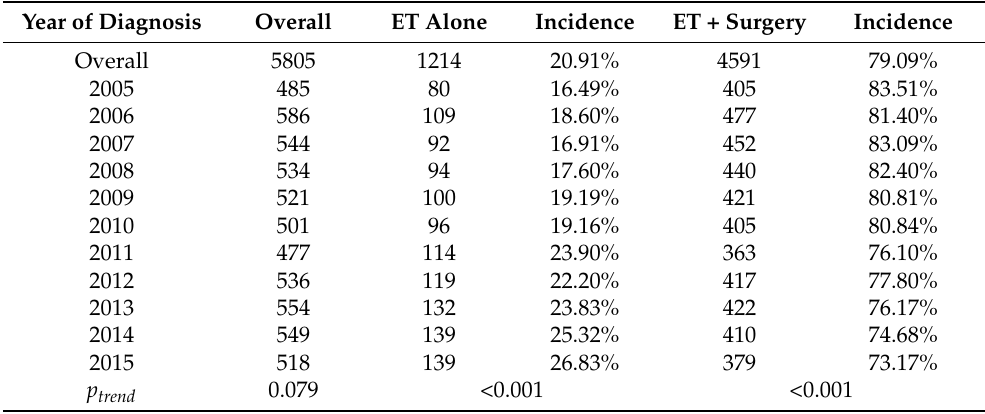
Table 5. Time trend analysis of the use of salvage surgery for patients underwent endoscopic removal of invasive